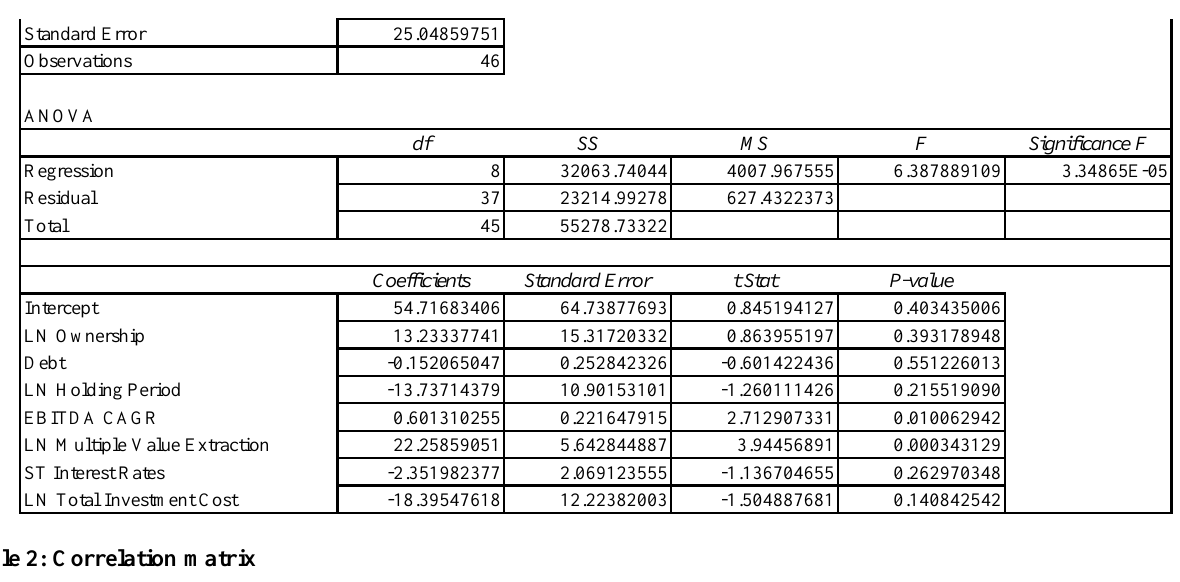
Table 1: Multiple regression output